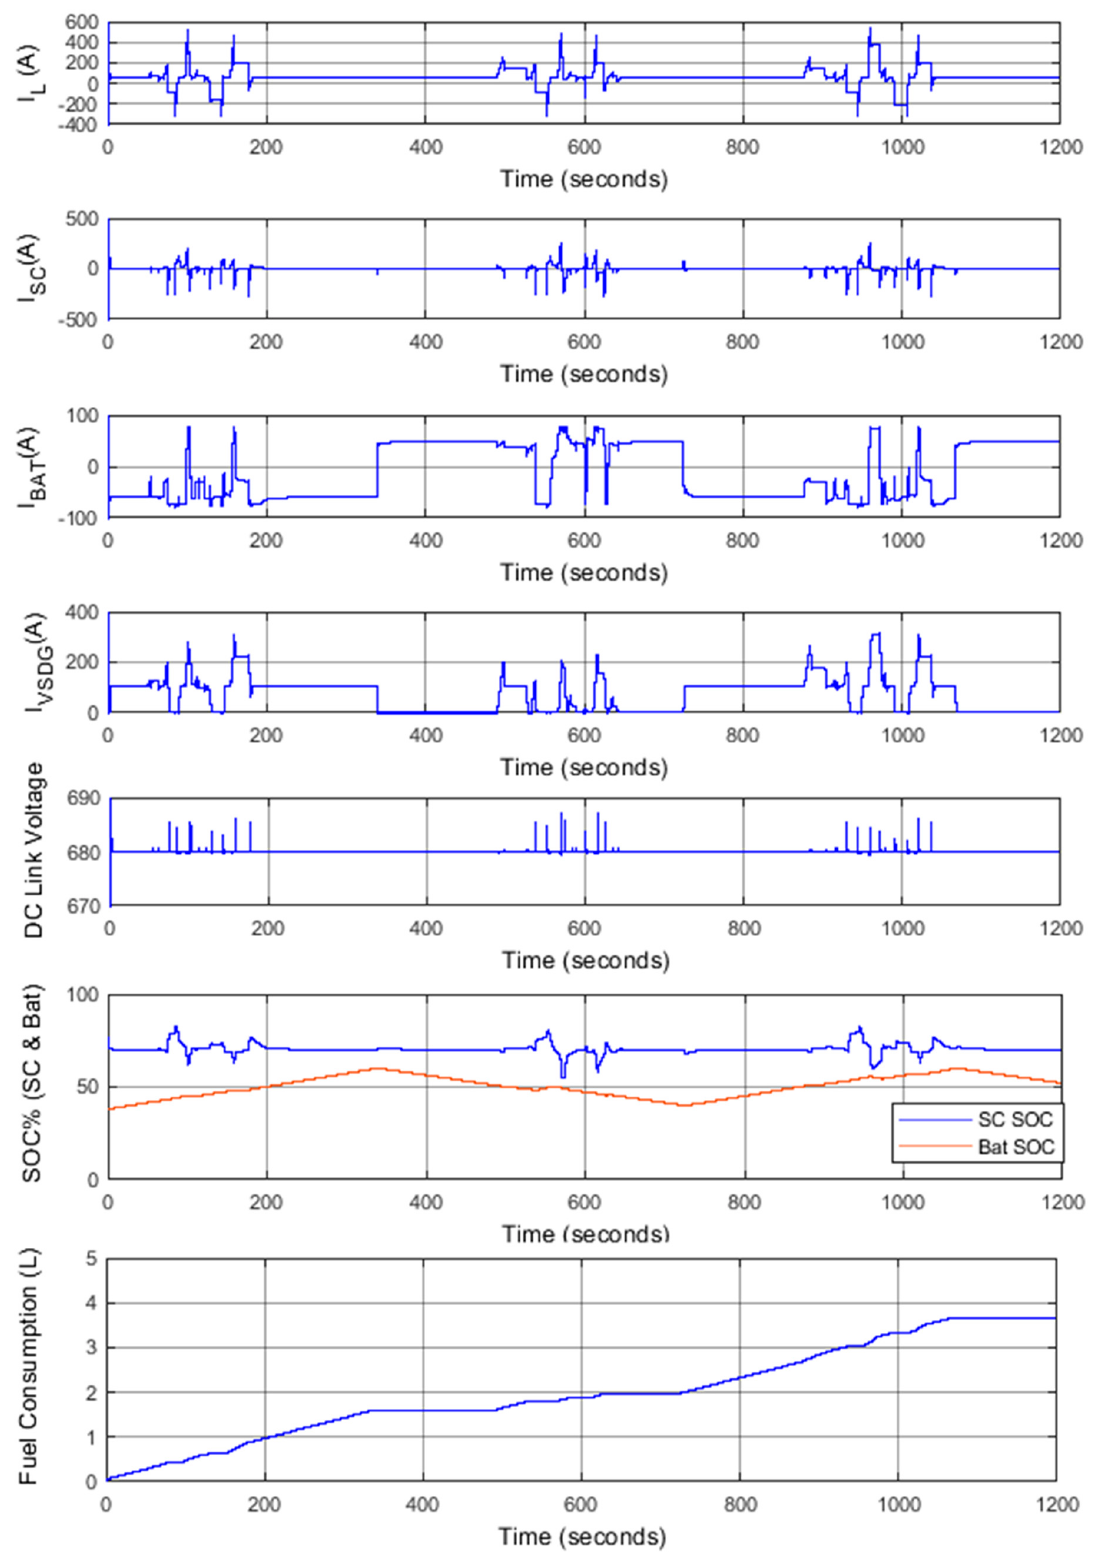
Figure 12. SOC and current variations of Case 1